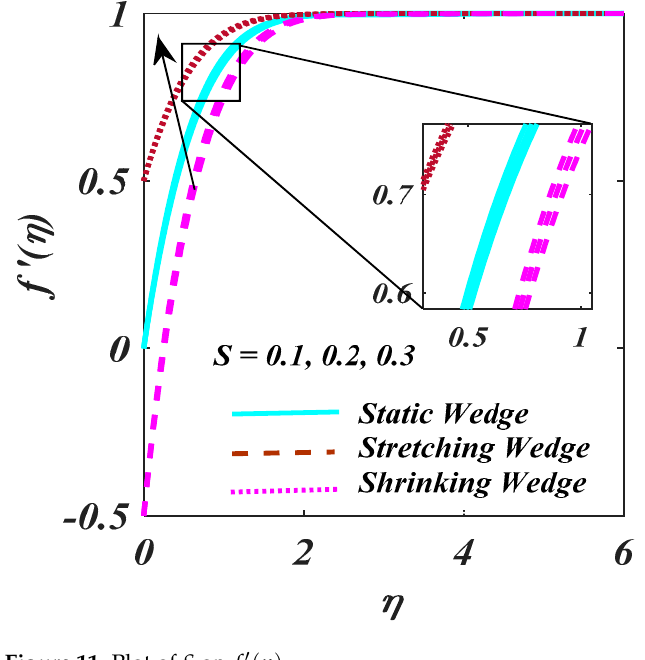
Figure 11. Plot of (cid:1845) on (cid:1858)′(cid:4666)(cid:2015)(cid:4667). Figure 11. Plot of S on f